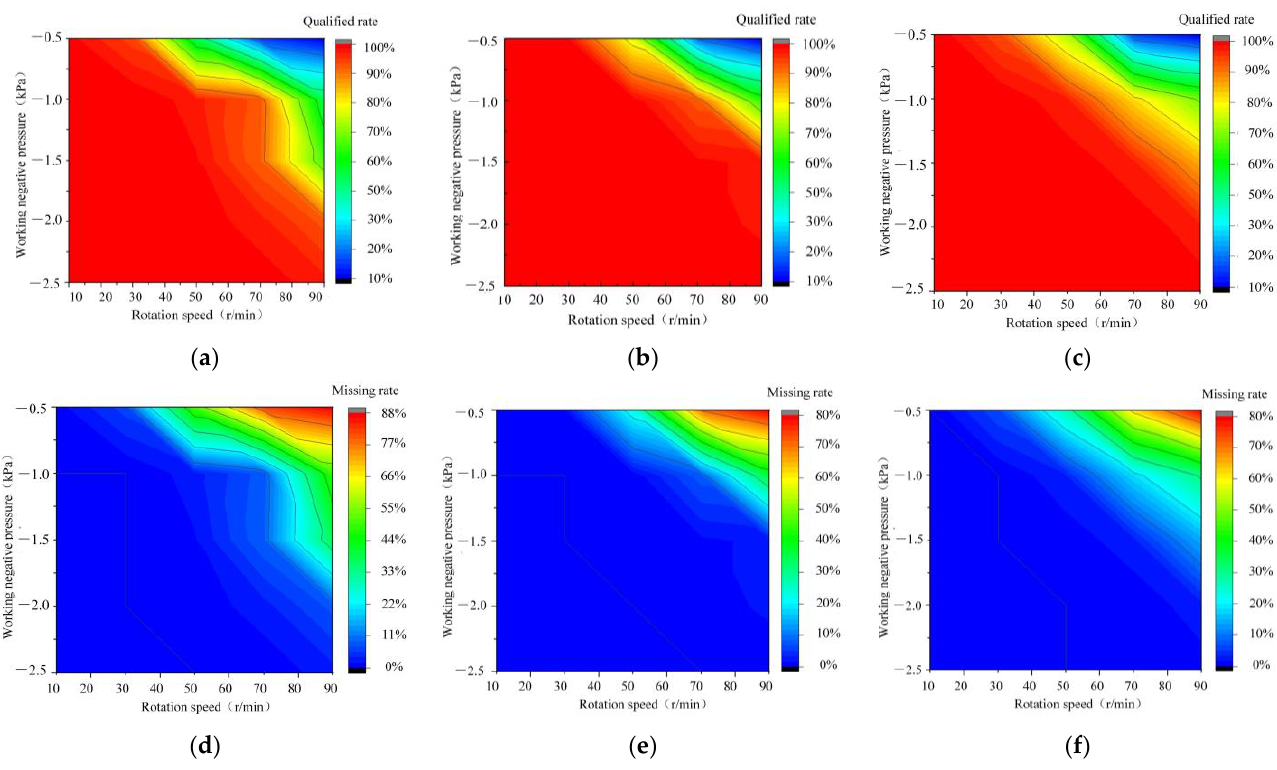
Figure 15. Various diameters of suction hole performance contour map. ( a ) 1.1 mm diameter of suction hole filling qualified rate contour map; ( b ) 1.2 mm diameter of suction hole filling qualified rate contour map; ( c ) 1.3 mm diameter of suction hole filling qualified rate contour map; ( d ) 1.1 mm diameter of suction hole leakage rate contour map; ( e ) 1.2 mm diameter of suction hole leakage rate contour; ( f ) 1.3 mm diameter of suction hole leakage rate contour.